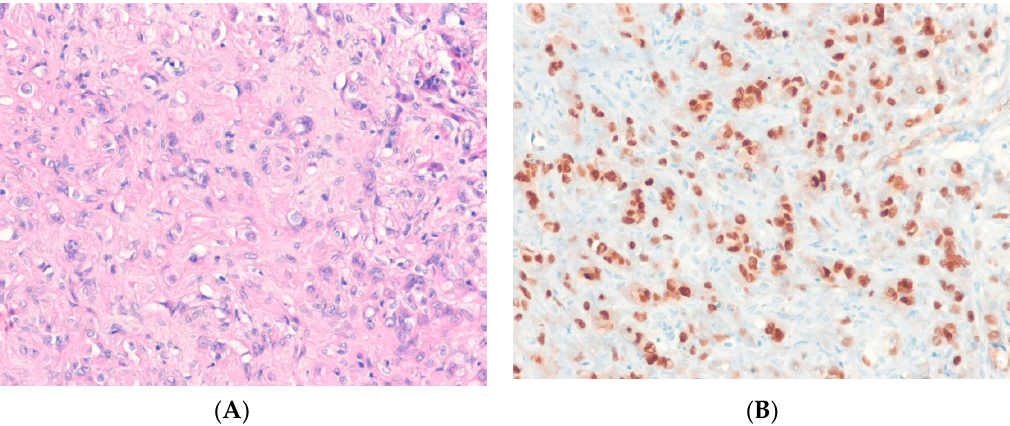
Figure 5. Epithelioid hemangioendothelioma. ( A ) The tumor cells show epithelioid cells with oval or round nuclei and variable amounts of eosinophilic cytoplasm in myxohyaline stroma. Intracytoplasmic vacuoles are present (H&E stain, ×100). ( B ) The tumor cells show strong nuclear expression of CAMTA1, indicating the presence of an underlying WWTR1 :: CAMTA1 fusion gene (immunohistochemical stain for CAMTA1, ×200).